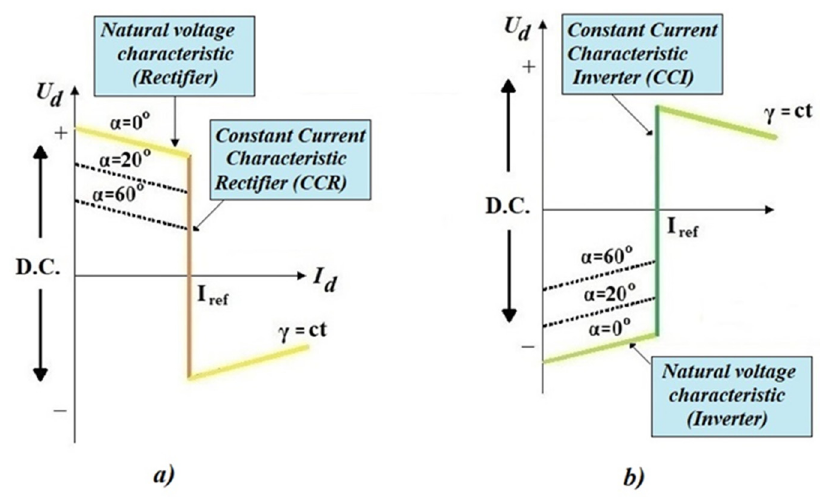
alue Δ I m = I 0r − I 0i is called the current margin, and it has a value of 0.1–0.15 p.u. of the desired DC current value. Figure 11. LCC-HVDC-U-I ideal characteristics ( a ) rectifier, ( b ) inverter. Figure 11. LCC-HVDC-U-I ideal characteristics ( a ) rectifier, ( b ) inverter. Both the inverter and the rectifier are equipped with a fast current regulator, with a reference value of I 0i for the inverter and I 0r for the rectifier ( I 0i is smaller than I 0r ), Figure 12a. The v